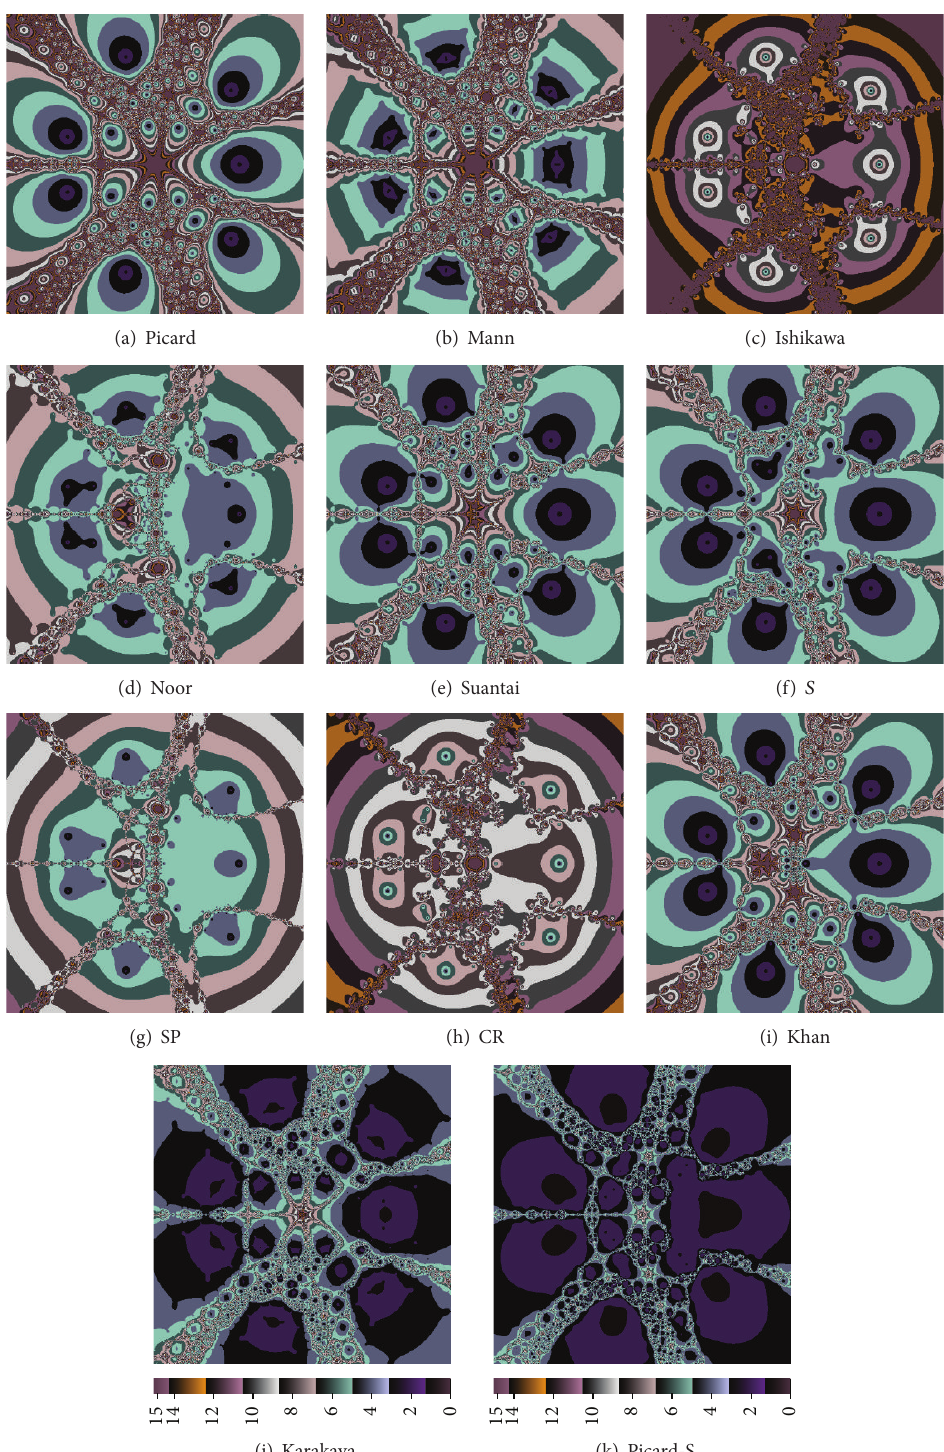
Figure 2: Examples of polynomiographs for 𝑝 1 with real-valued parameters of